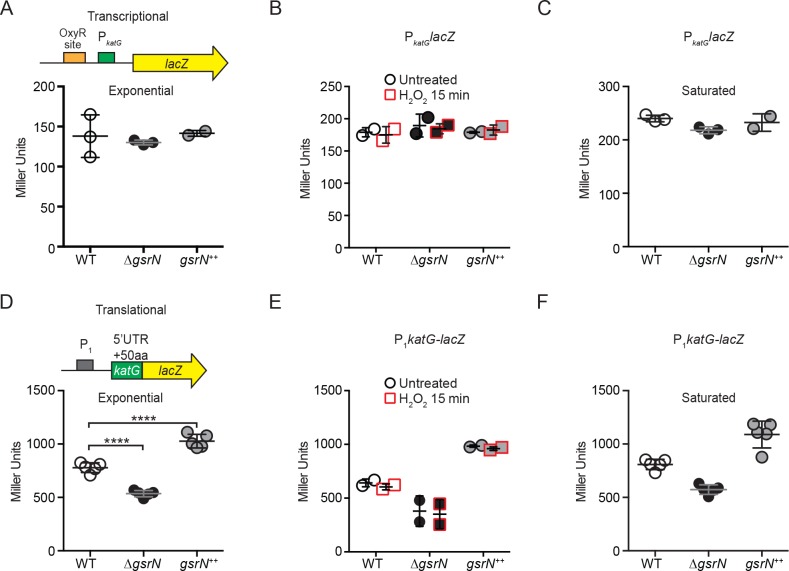
gsrN does not regulate katG transcription, but does enhance katG-lacZ mRNA translation.(A) katG transcriptional reporter construct contains the entire intergenic region upstream of katG fused to lacZ in pRKlac290. Transcription from this katG promoter (PkatG) reporter was assayed in wild type, ΔgsrN, and gsrN++ backgrounds during exponential growth (OD660 ≈ 0.2–0.25). Data represent mean ±SD of three independent trials. (B) Activity from the katG transcriptional reporter with and without a 15 min treatment with 0.2 mM hydrogen peroxide. These conditions were chosen to evaluate peroxide effects without ablating the ΔgsrN cultures. Cells were grown as in (A). Data represent mean ±SD of two independent trials. (C) Activity from the katG transcriptional reporter in stationary phase cultures (OD660 ≈ 1.0, a condition in which OxyR activates transcription [Italiani et al., 2011]). Data represent mean ±SD of three independent trials. (D) KatG translational reporter (top) assayed in exponentially growing cells (bottom). Reporter is constitutively expressed from the PrpoD1 promoter. katG leader (1–191 nt) region and the first 50 katG codons are fused in-frame to lacZ. Mean ±SD β-galactosidase activity, measured in Miller Units, presented from five independent trials. (E) Activity from the katG translational reporter was assayed in wild type, ΔgsrN, and gsrN++ with and without a 15 min treatment with 0.2 mM hydrogen peroxide as in (B). Cells were grown as in (A). Data represents mean ±SD from two independent trials. (F) Translation from katG leader fusion reporter was assayed in stationary phase cultures (OD660 ≈ 1.0). Data represents mean ±SD from five independent trials.